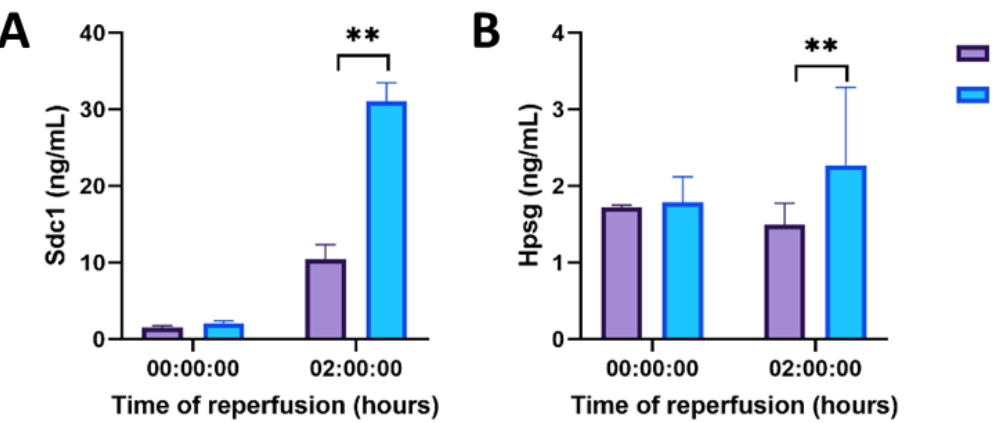
Figure 7. Glycocalyx integrity during reperfusion at 37 °C following 24 h of SCS and 2 h of HOPE. Proteins expression of SDC1 and HPSG by ELISA were measured from perfusates. ( A ) SDC1 levels were significantly lower after 2 h of reperfusion in the IGL2 group ( p < 0.01). ( B ) HPSG levels were significantly lower after 2 h of reperfusion in the IGL2 group ( p < 0.01). n = 6/group. ** = p < 0.01.